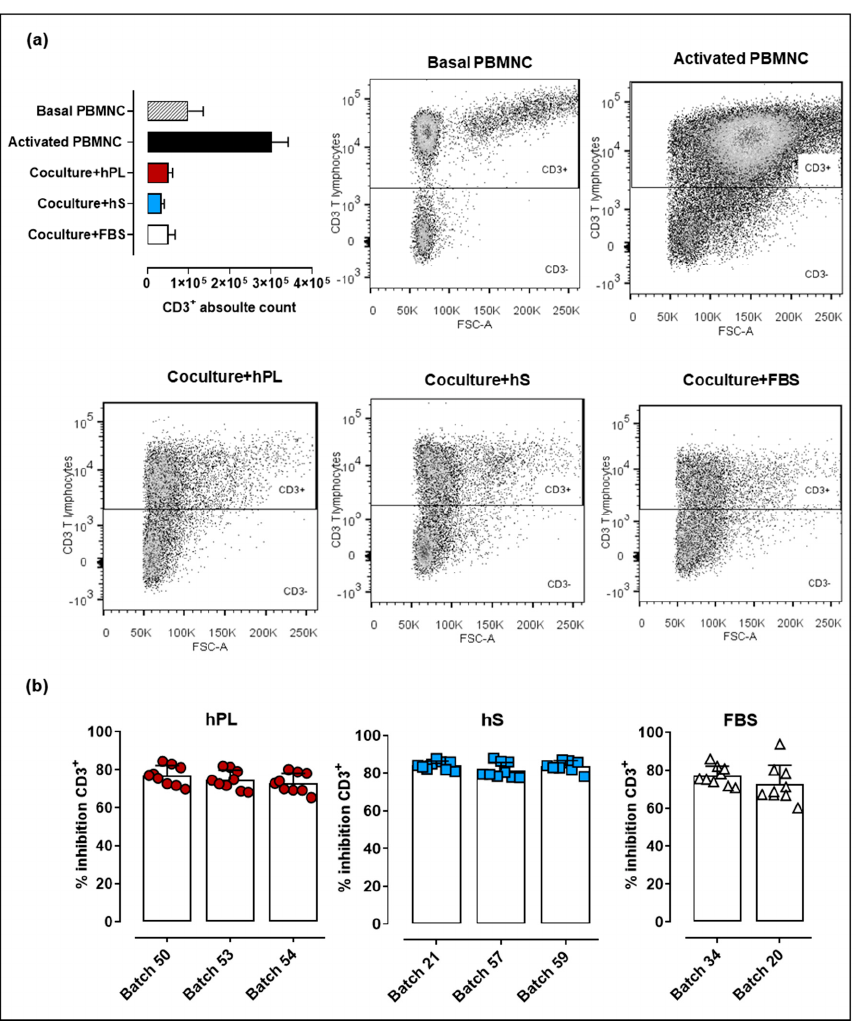
Figure 6. Immune suppressive potency of WJ-MSC expanded with hPL, hS and FSB ( a ) CD3 +